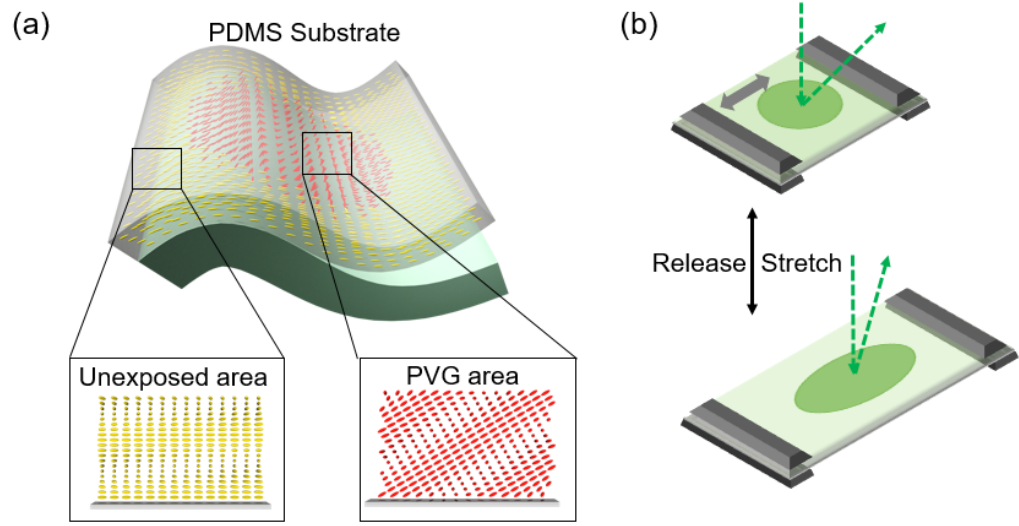
Figure 12. ( a ) Schematic illustration of stretchable PVG film. ( b ) Schematic diagram of mechanically controlled PVG film for continuous beam steering.